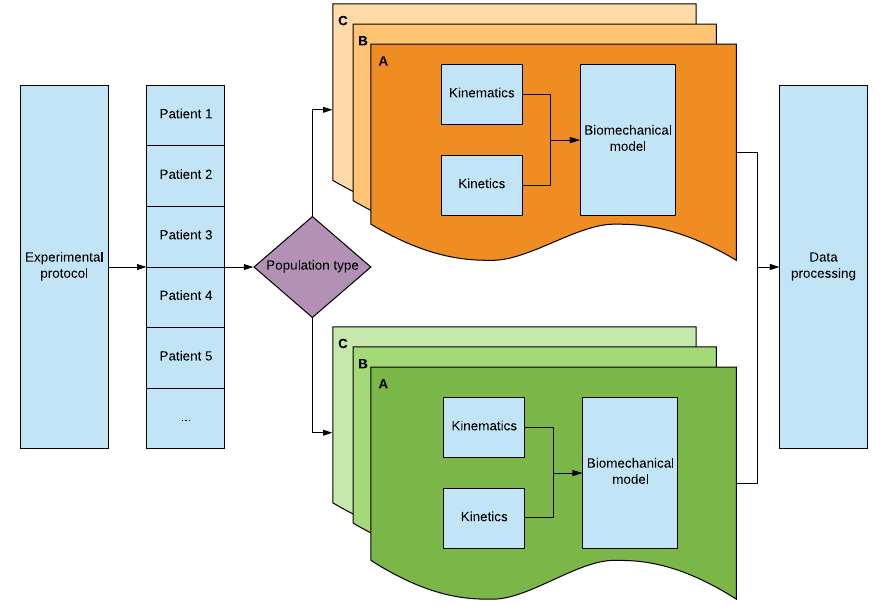
Figure 1. Diagram of the methodology developed which allows to study different patient populations using several